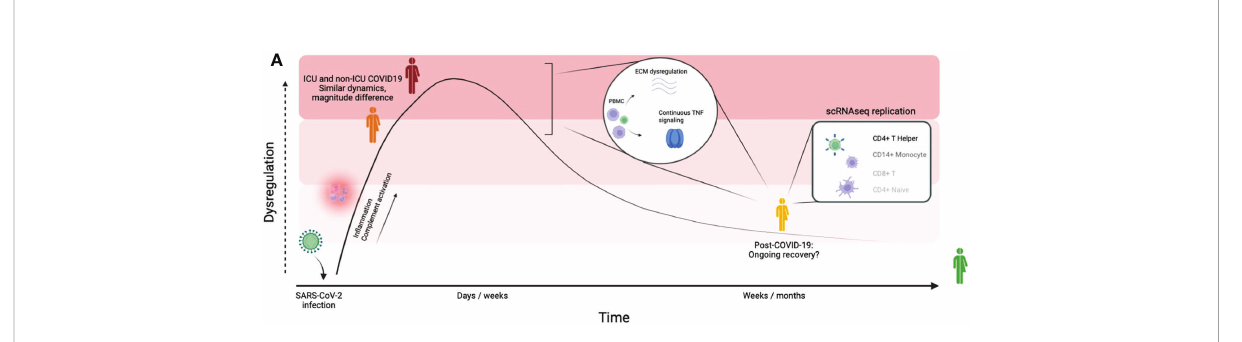
FIGURE 6 Graphical summary of our fi ndings. Graphical summary of the main fi ndings in this study. By integrating a large disease spectrum including variation in disease severity, course and recovery we show the proteomic changes induced by SARS-CoV-2 infection during the acute phase and the post-COVID-19